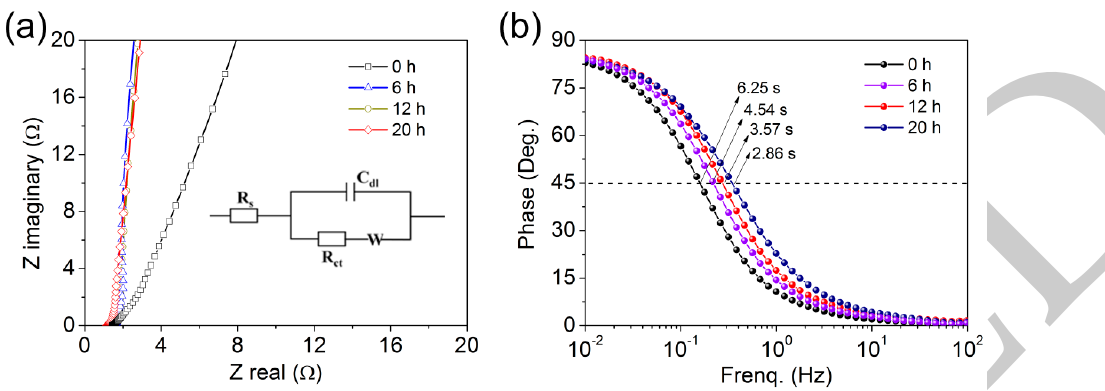
Figure 8. CV profiles of ( a ) Ti 3 C 2 T x and ( b ) 20 h N-TiO 2 /TiN/Ti 3 C 2 T x at different scan rates. The GCD curves for ( c ) Ti 3 C 2 T x and ( d ) 20 h N-TiO 2 /TiN/Ti 3 C 2 Tx at current densities of 1, 2, 5, and 10 A g − 1 . ( e ) Gravimetric specific capacitances at different scan rates. ( f ) Gravimetric specific capacitances at different current densities of Ti 3 C 2 T x , 6 h, 12 h and 20 h N-TiO 2 /TiN/Ti 3 C 2 T x electrodes.